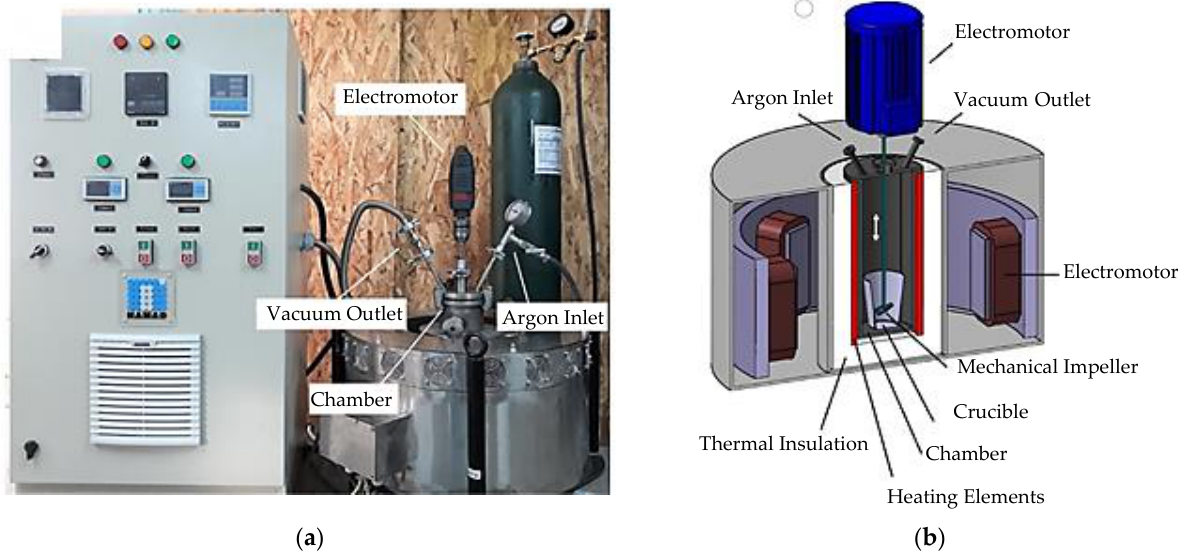
Figure 3. Developed casting machine: ( a ) different external parts, and ( b ) a schematic view of the main parts.